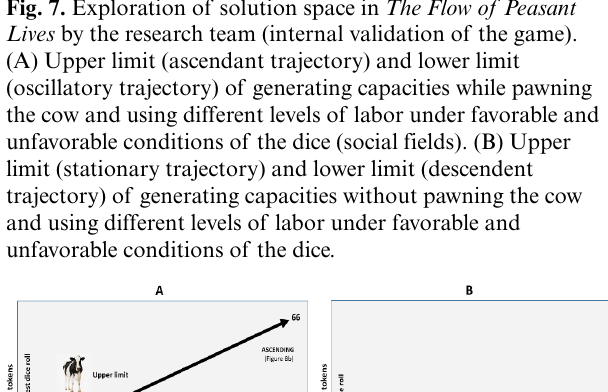
Fig. 8. (A) Simulation of a single household team using a playing strategy that obtains an outcome in the upper limit of the solution space in The Flow of Peasant Lives. Dice outcomes are assumed to favor the household team in every round. As with the strategy addressed in Fig. 7A, this strategy uses a full level of labor and balances household-keeping with earning monetary income but uses no savings. (B) Dynamics of stationary capacity reproduction resulting from the strategy shown in (A). The horizontal axis shows the sequence of